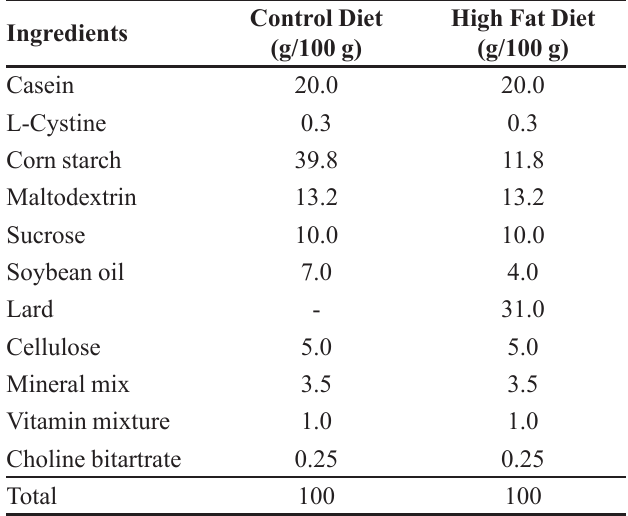
TABLE I - Composition of control diet and High fat diet